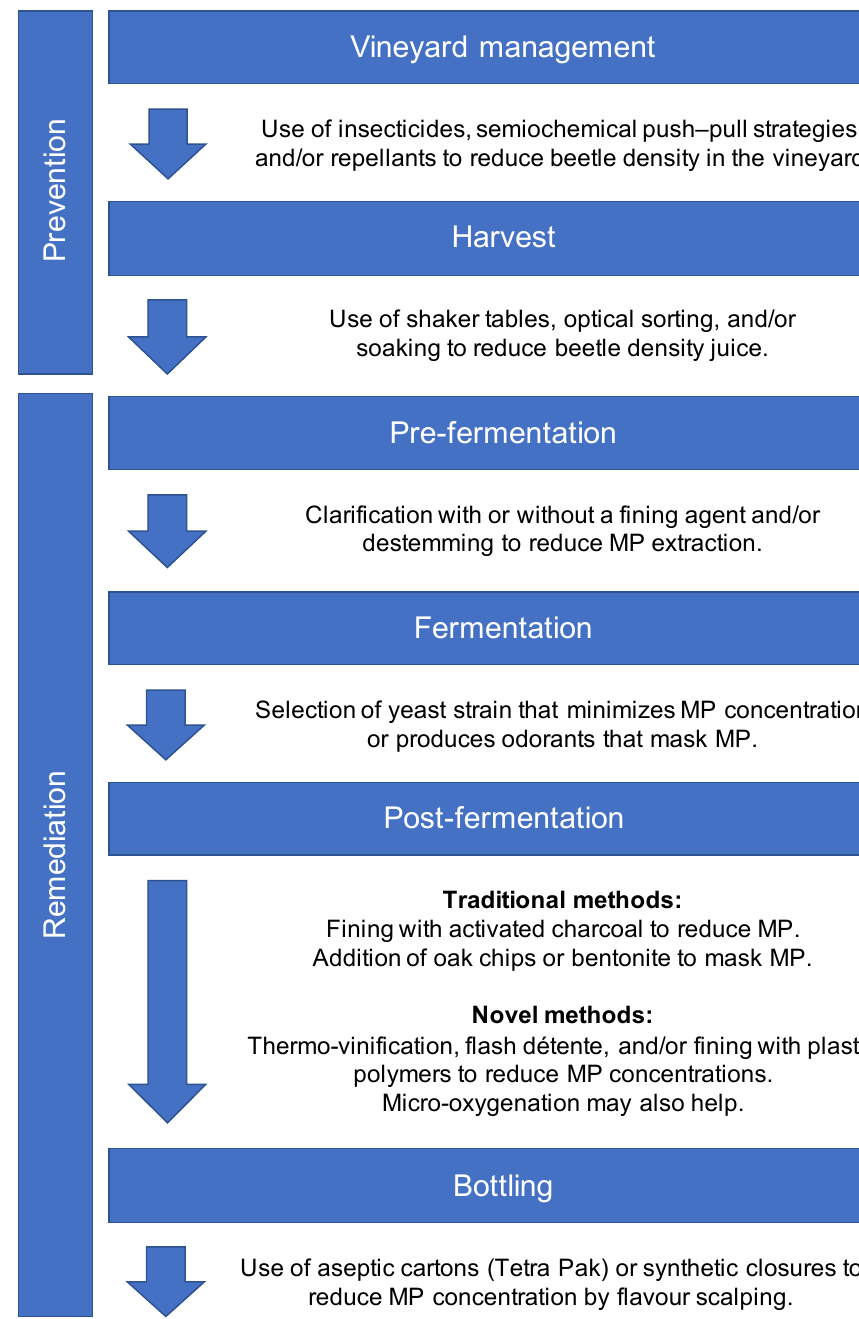
Figure 3. Summary of methods used to prevent or remediate ladybug taint during wine production.